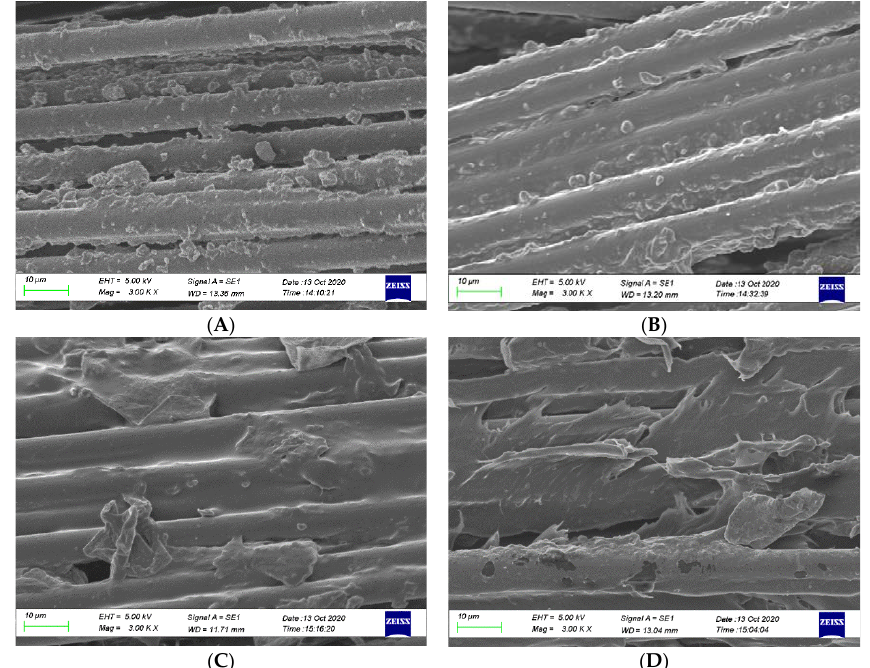
Figure 19. SEM micrographs of pull-out CF bundle at different processing parameters: ( A ) 210 °C/15 Figure19. SEMmicrographsofpull-outCFbundleatdi ff erentprocessingparameters: ( A )210 ◦ C / 15rpm / rpm/without pin/without treatment, ( B ) 210 °C/17 rpm/two pins/APTS, ( C )190 °C/13 rpm/three without pin / without treatment, ( B ) 210 ◦ C / 17 rpm / two pins / APTS, ( C )190 ◦ C / 13 rpm / three pins / nitrogen pins/nitrogen and ( D ) 230 °C/13 rpm/three pins/nitrogen. and ( D ) 230 ◦ C / 13 rpm / three pins / nitrogen.